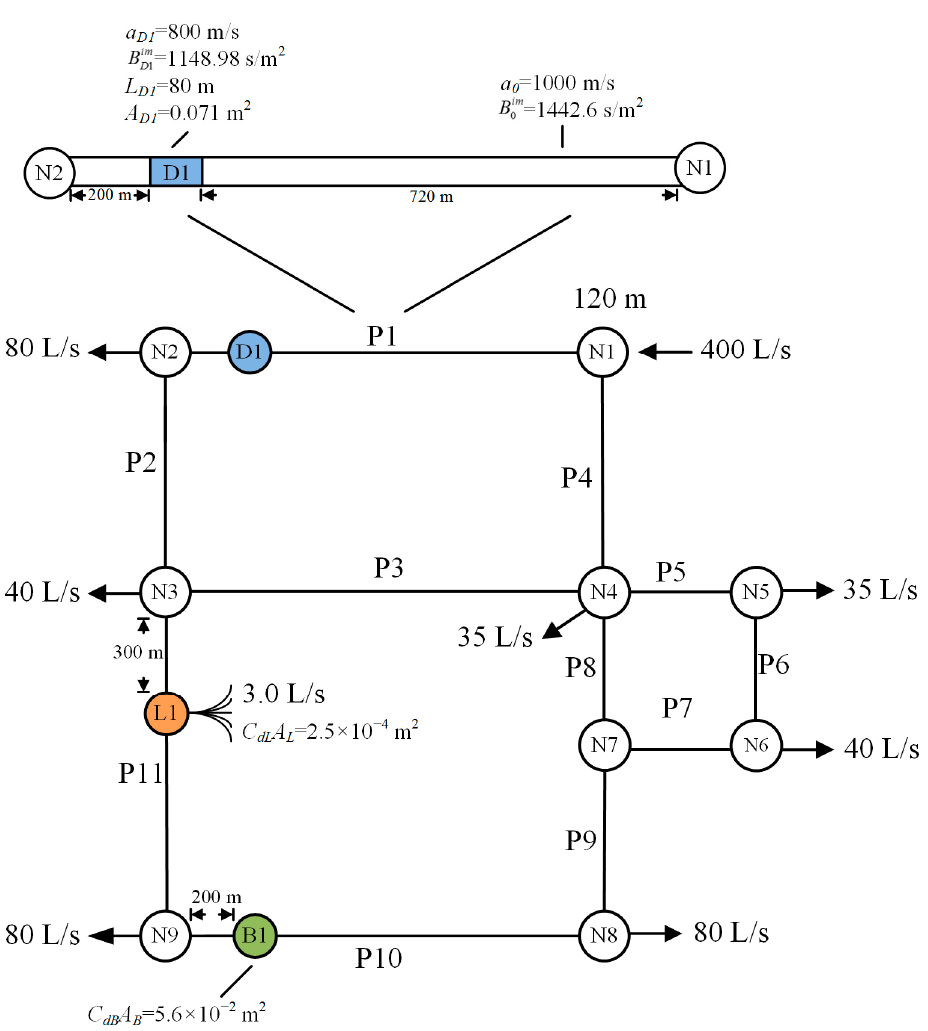
Figure 3. Configuration of pipe network A with a sectional view of P1.